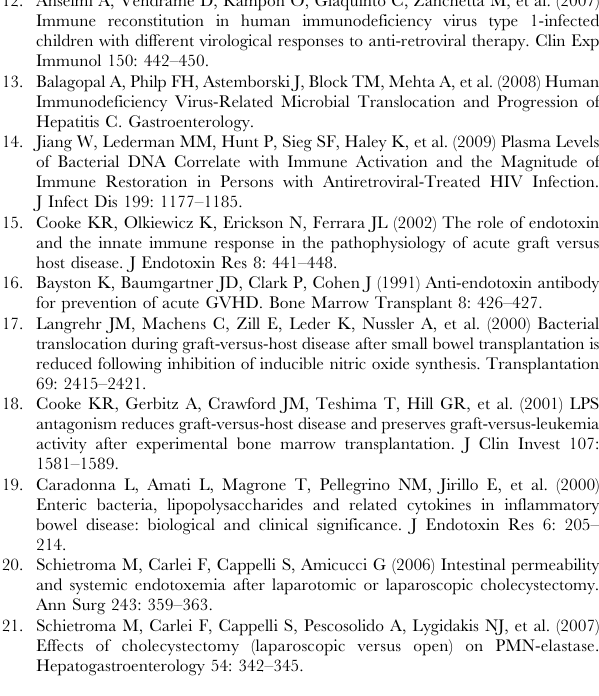
Figure S10 Damage to the integrity of the epithelial barrier is associated with increased enterocyte proliferation. Low magnifi- cation whole tissue (top panel), 40 6 (middle panel) and 100 6 (bottom panel) images from high power whole tissue scans of colon from SIV uninfected and chronically SIV + RMs immunohisto- chemically stained for Ki67 (brown). Rectangles represent regions of the colon magnified in the successive images, while the rectangles displayed in the 100 6 lower panel images represent the region magnified and displayed in Figure 9. Scale bars = 1 mm. Found at: doi:10.1371/journal.ppat.1001052.s010 (4.66 MB TIF) Figure S11 Quantitative image analysis of the frequency of HAM56 + macrophages that are E. coli + compared to the proportion of HAM56 2 E.coli + events in SIV-uninfected and acutely and chronically SIV-infected RMs. Note that throughout the acute phase of infection (1–21 dpi), most microbial products are within or associated with macrophages, however, starting at 28 dpi and extending into the chronic stage macrophages, although still abundant in the GI tract, become progressively inefficient/ dysfunction in their ability to bind and/or phagocytose microbial products that cross the epithelial barrier. Found at: doi:10.1371/journal.ppat.1001052.s011 (0.13 MB